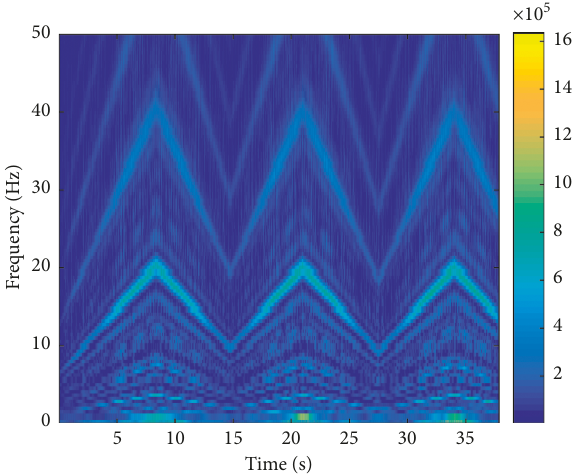
Figure 25: Time-frequency representation of rolling bearing vi- bration signal with fluctuated speed based on